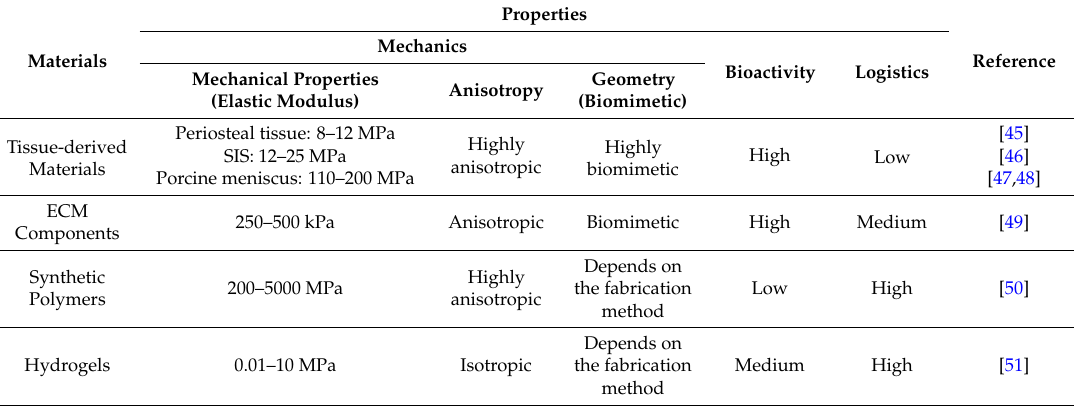
Table 1. Properties of different types of materials used in engineered meniscal